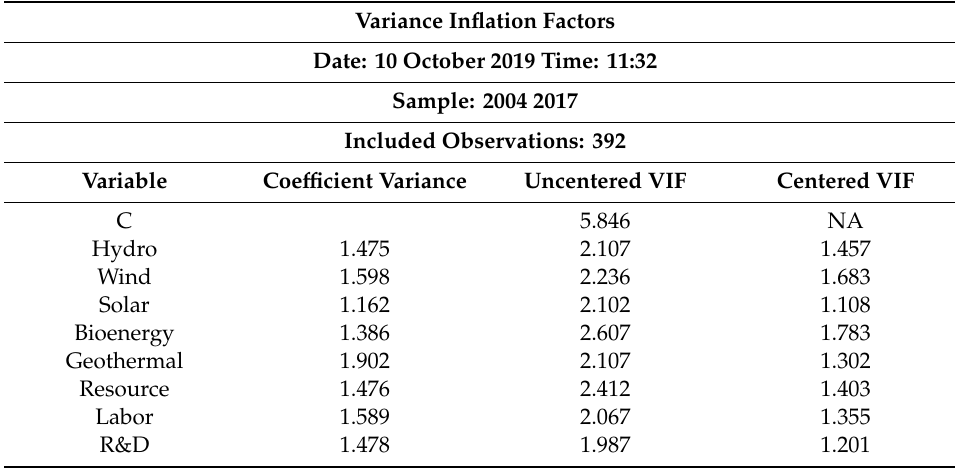
Table 10. The Variance Inflection Factor (VIF) test for